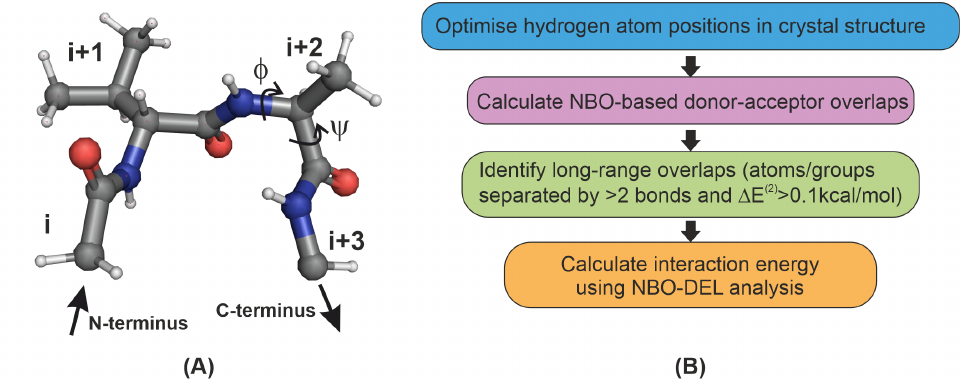
Figure 1. ( A ) Typical tetrapeptide showing the i + 1 and i + 2 residues at a β -turn and the backbone ( φ , ψ ) angles used in this work. ( B ) Flowchart of the steps used in identifying donor-acceptor interactions. See Section 4 for a description of the second order perturbation energy ∆ E ( 2 ) .